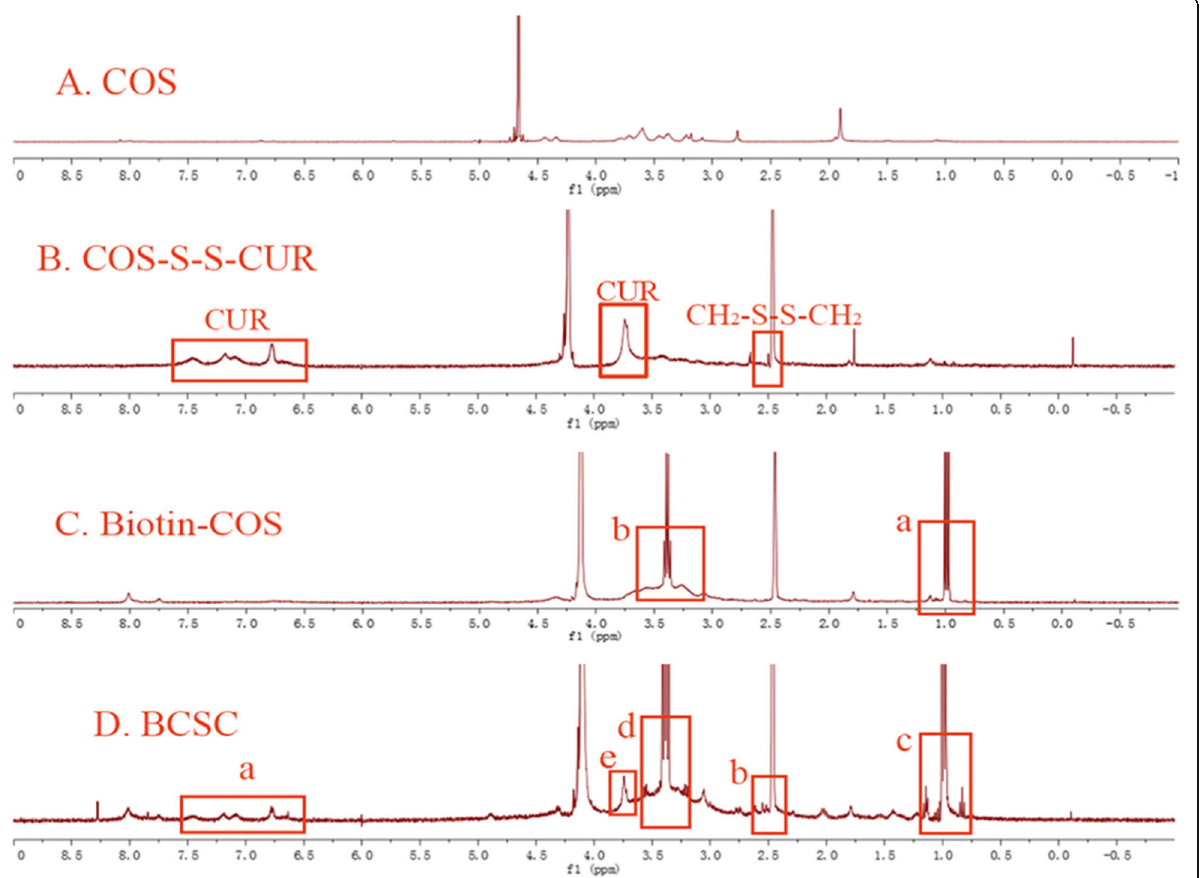
Fig. 3 The 1 H-NMR spectra of COS ( A ), COS-S-S-CUR ( B ), Biotin-COS ( C ), and BCSC ( D